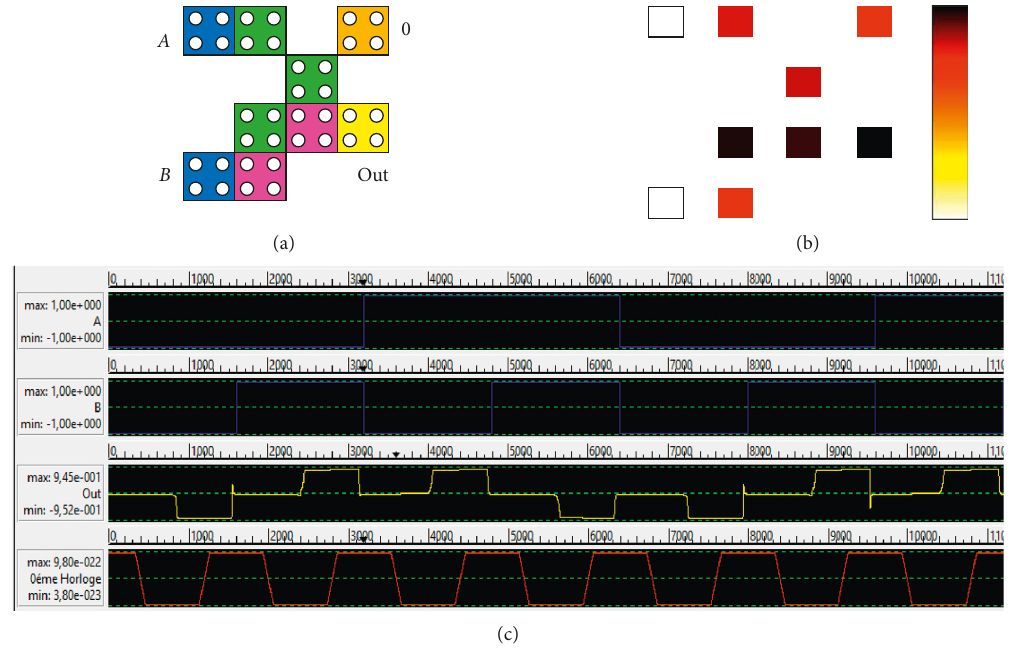
Figure 6: QCA layout of the designed (a) XOR gate, (b) power map, and (c) simulation